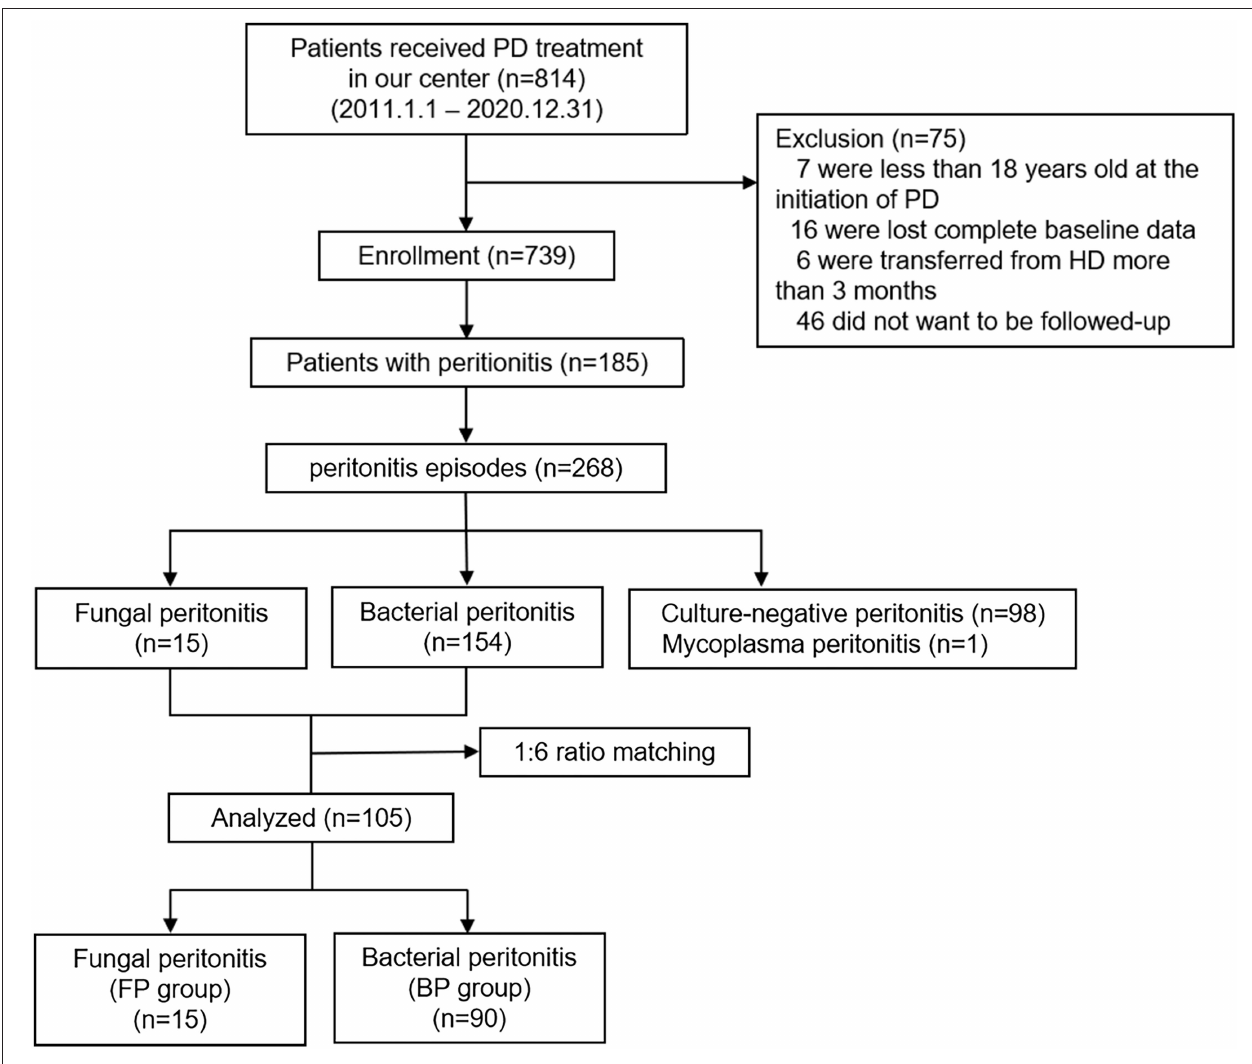
FIGURE 1 | Study flow